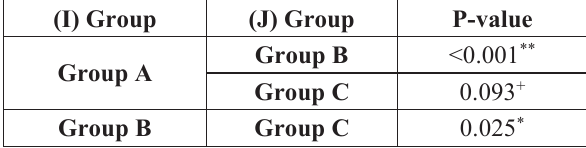
Table-2: Group wise comparison for status of Graafian follicles in control group A, experimental groups B and